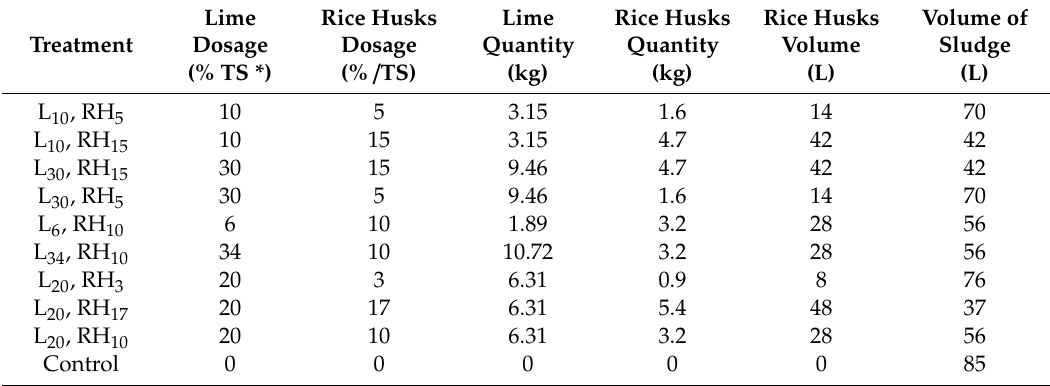
Table 1. Details of the treatments and control. L: lime; RH: rice husks.